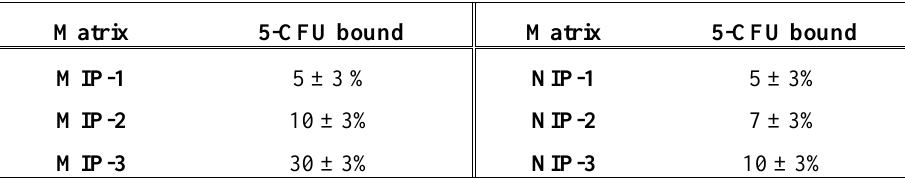
Table 2 . Percentage of bound 5-FU by the imprinted and non-imprinted polymers after 24 hours in organic medium (i.e., acetonitrile).